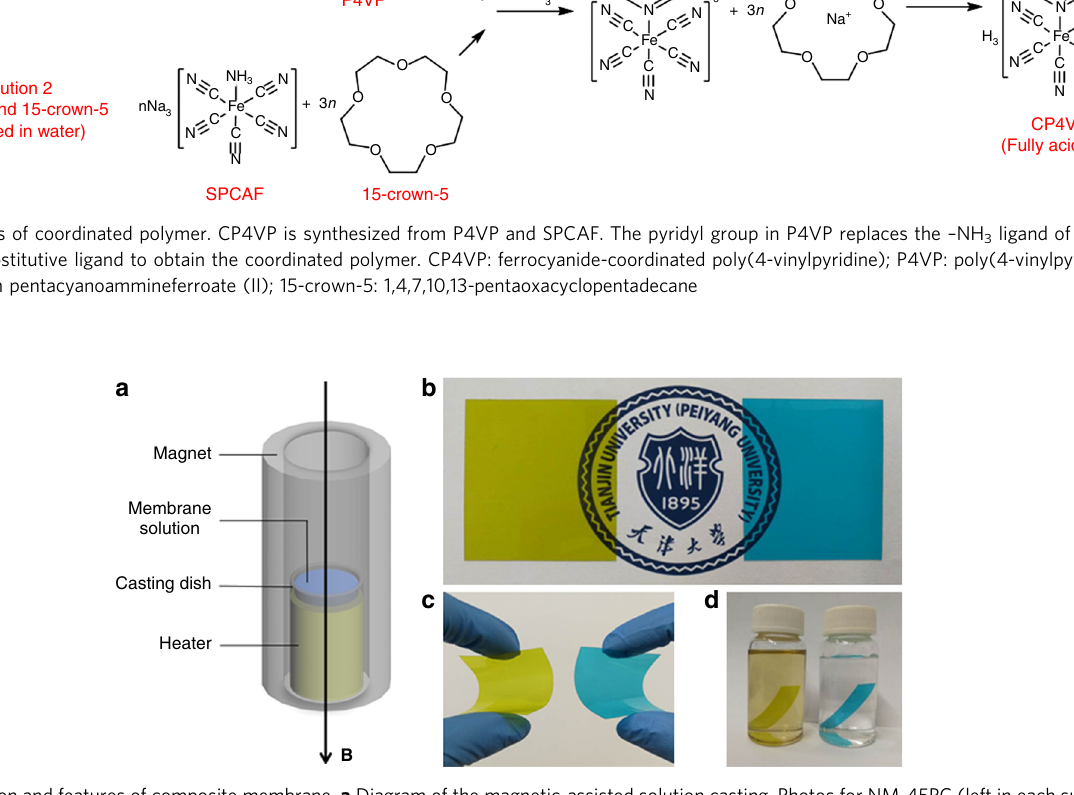
Fig. 2 Fabrication and features of composite membrane. a Diagram of the magnetic-assisted solution casting. Photos for NM-45PC (left in each sub fi gure) and MM-45PC (right in each sub fi gure) to show their appearances. b Both membranes are visibly homogeneous and transparent. c Both membranes are fl exible due to the tough PSf matrix. d NM-45PC membrane shows leaching of the colored PC component CP4VP in water, but MM-45PC is insoluble. NM-45PC: normal-cast membrane with 45 wt% loading of proton-conducting components; MM-45PC: magnetic-cast membrane with 45 wt% loading of proton-conducting components; PSf: polysulfone; PC: proton-conducting components; CP4VP: ferrocyanide-coordinated poly(4-vinylpyridine)